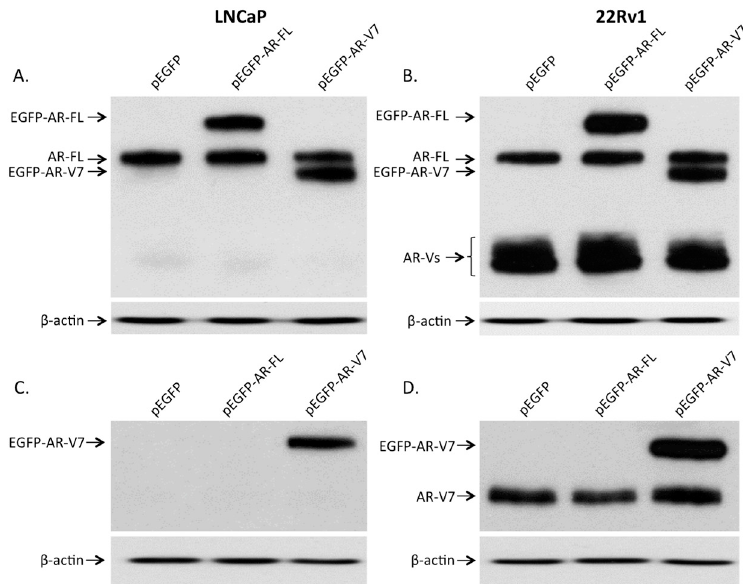
Figure 2. Expression of full-length androgen receptor (AR) and its variants in transfected prostate cancer cells. LNCaP ( A ) and 22Rv1 ( B ) cells were transfected with pEGFP, pEGFP-AR-FL, or pEGFP-AR-V7 expression plasmids. Immunoblot was carried out to detect the expression of endogenous and recombinant AR and its variants. Antibody against an internal region of AR was used to detect the expression of full-length AR (AR-FL) and its variants (AR-Vs). Cells transfected with pEGFP-AR-FL or pEGFP-AR-V7 expression plasmids expressed EGFP-tagged AR-FL (EGFP-AR-FL) or EGFP-tagged AR-V7 (EGFP-AR-V7), respectively. An antibody specifically against AR-V7 was also used to detect endogenous AR-V7 (AR-V7) and EGFP-tagged AR-V7 (EGFP-AR-V7) in LNCaP ( C ) and 22Rv1 ( D ) cells. β -actin was used as an internal control.